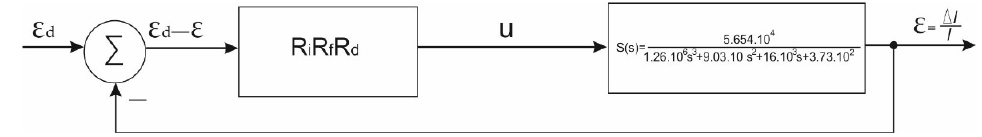
Figure 23. Block diagram of the control closed-loop circuit.